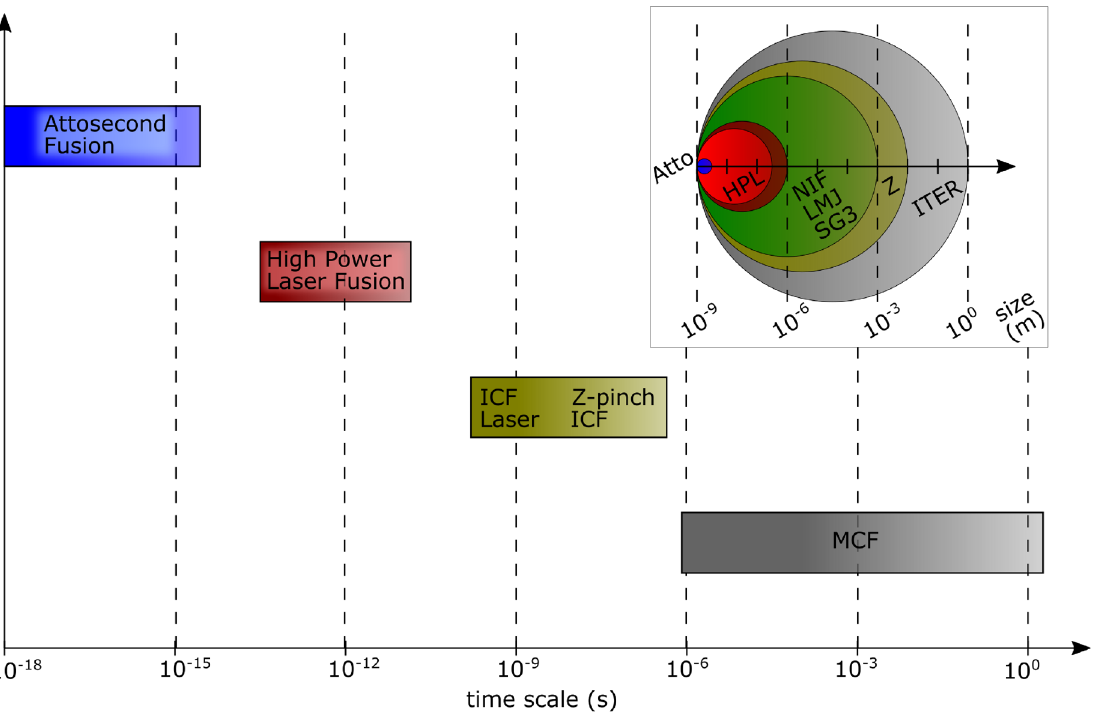
Figure 1. Landscape of nuclear fusion with the corresponding fusion schemes and facilities on different time and space scales i.e. from attosecond fusion to magnetic confinement